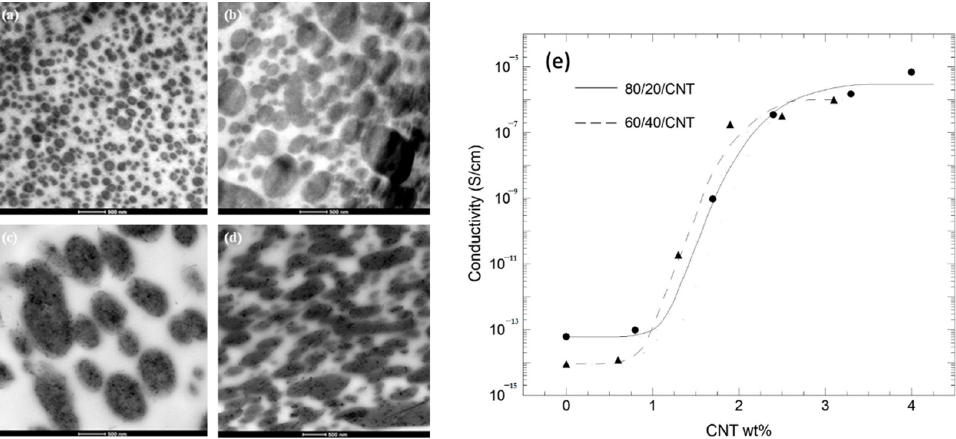
Figure 9. ( a , b ): TEM micrographs of 80/20 and 60/40 PLA/PBAT blends and ( c , d ) their corresponding nanocomposites with 2.4 and 1.8 wt%, respectively, of MWCNT; ( e ) conductivity as a function of MWCNT. Reprinted (adapted) with permission from Ref. [136] Copyright 2017 Elsevier.